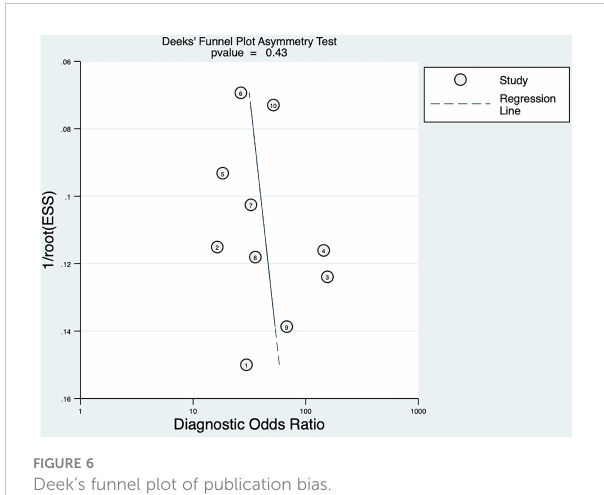
FIGURE 6 Deek ’ s funnel plot of publication bias.